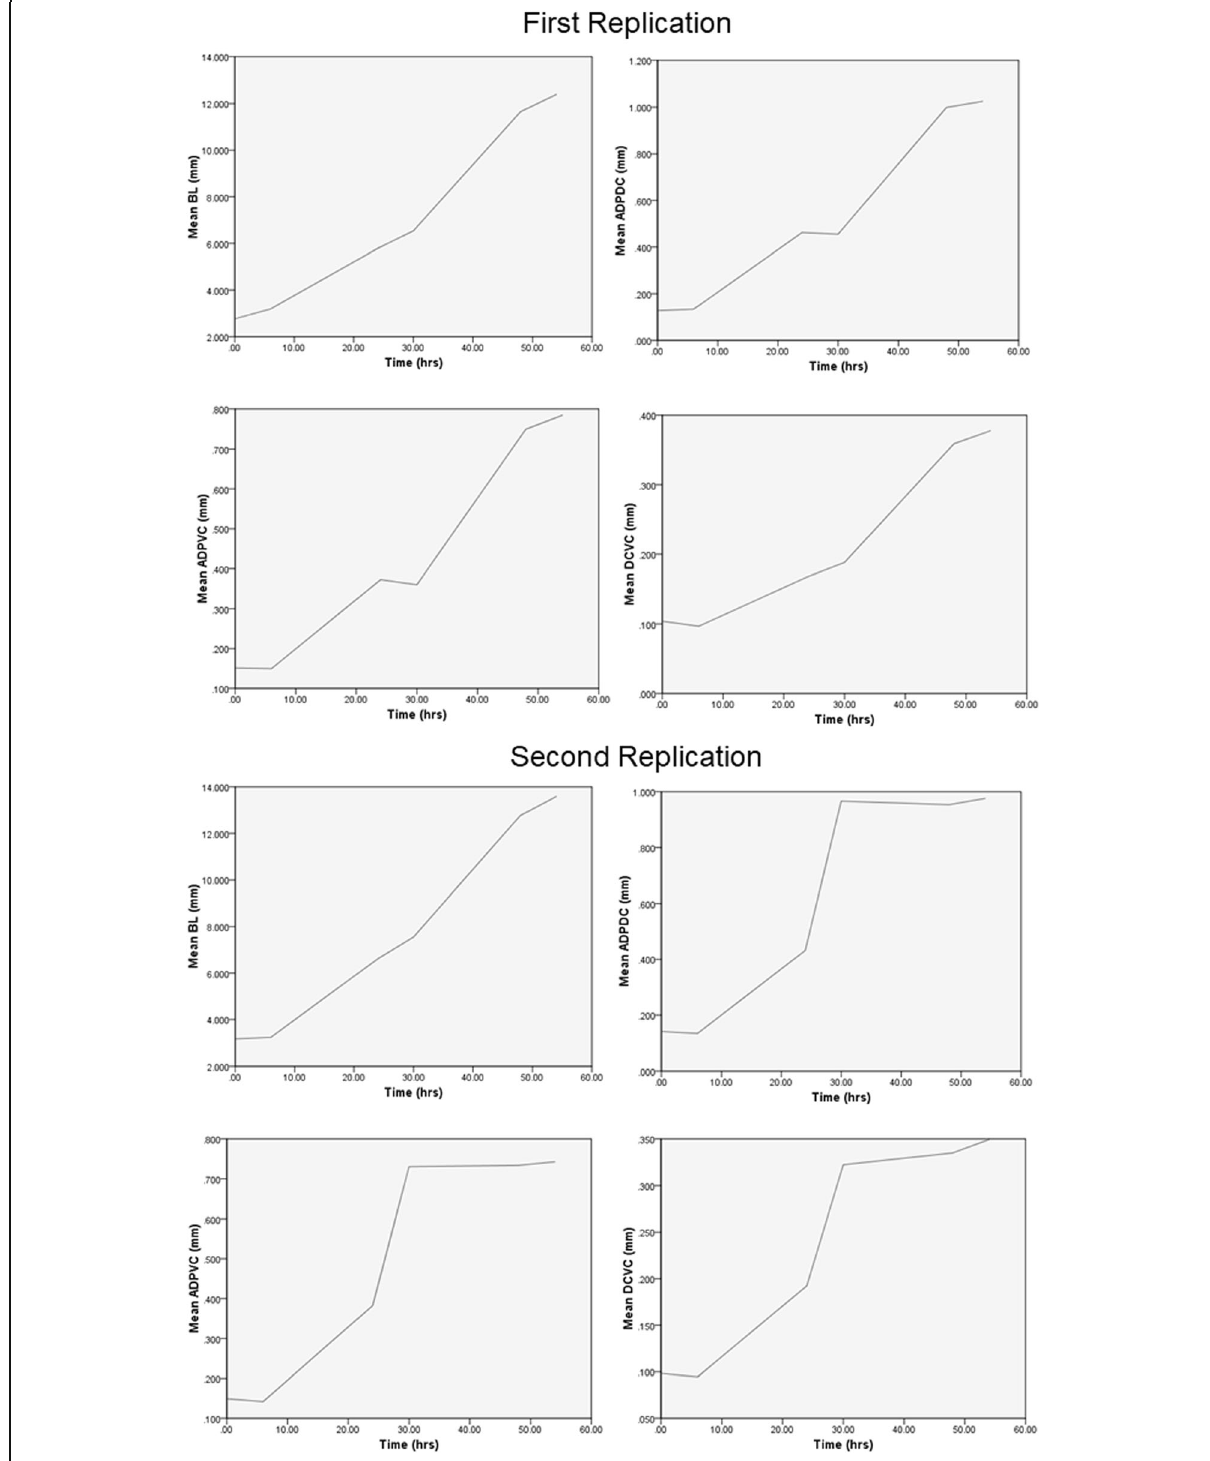
Fig. 2 Developmental rate of larval body length and cephalopharyngeal skeleton (ADP-DC Anterodorsal process-dorsal cornua, ADP-VC Anterodorsal process-ventral cornua, DC-VC Dorsal cornua-ventral cornua) of H. ligurriens in the first and second study